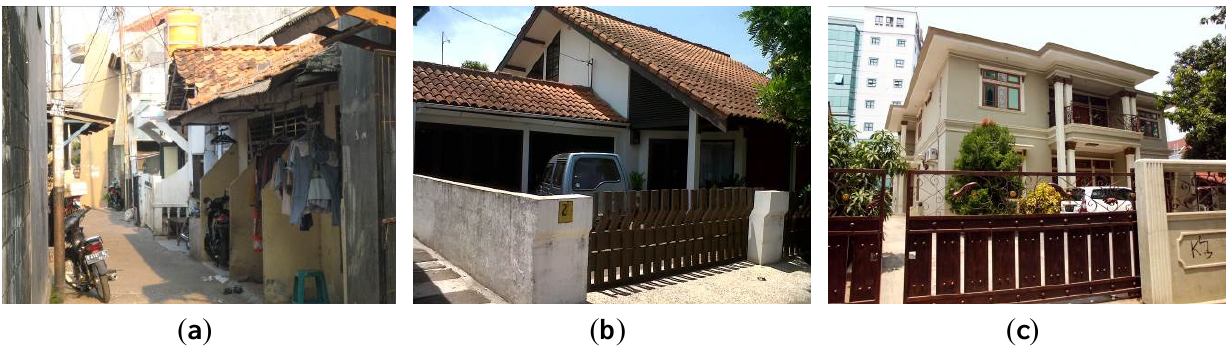
Figure 1 . Views of sample residential buildings: ( a ) simple house; ( b ) medium house; and ( c ) luxurious